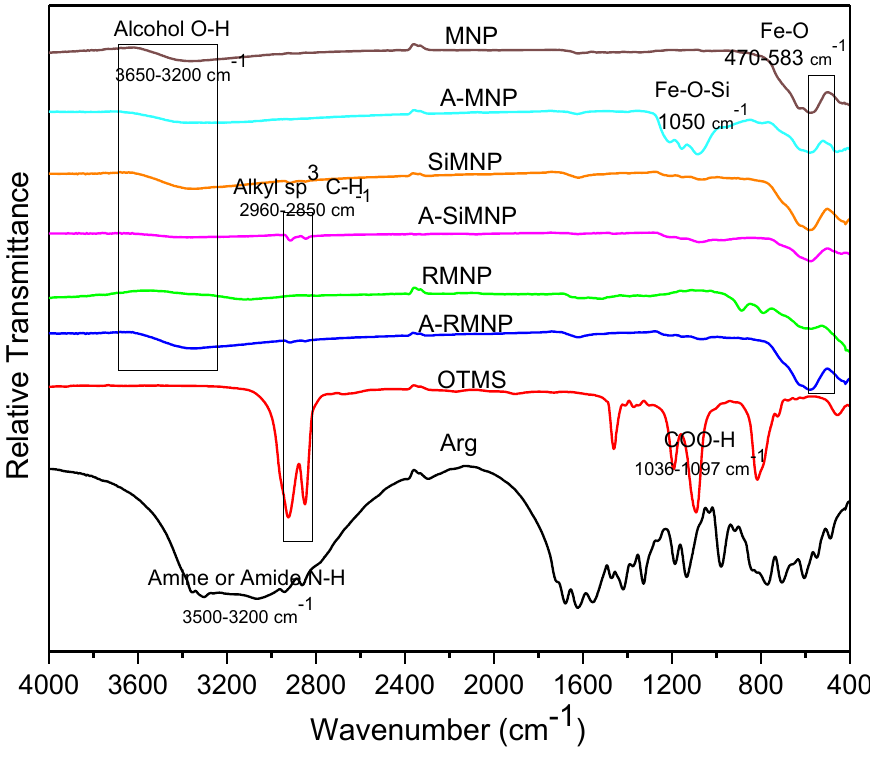
Figure 5. FTIR spectra of all the Figure 5 . FTIR spectra of all the MNPs.